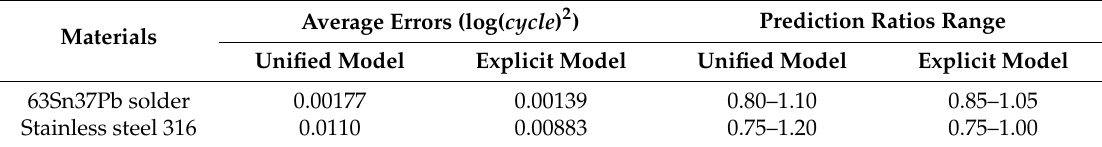
Table 8. Accuracy of prediction regarding the empirical-data